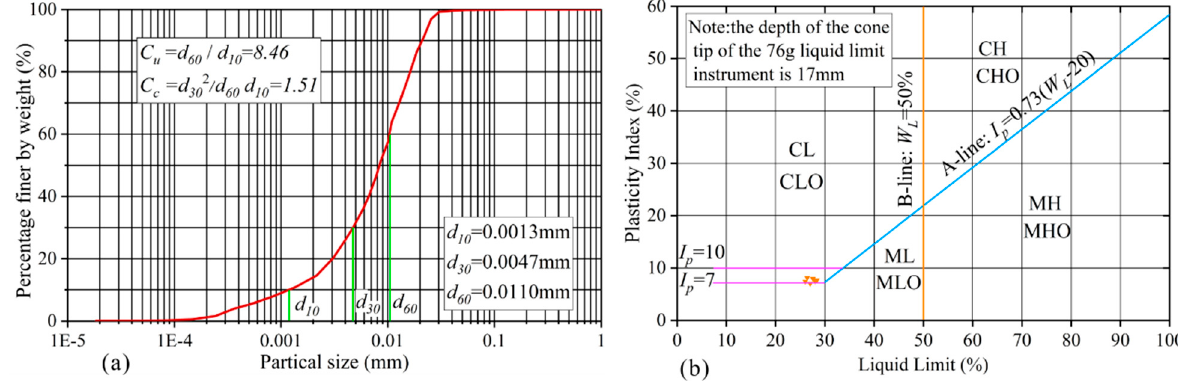
Figure 2. Location map of the sampling site.